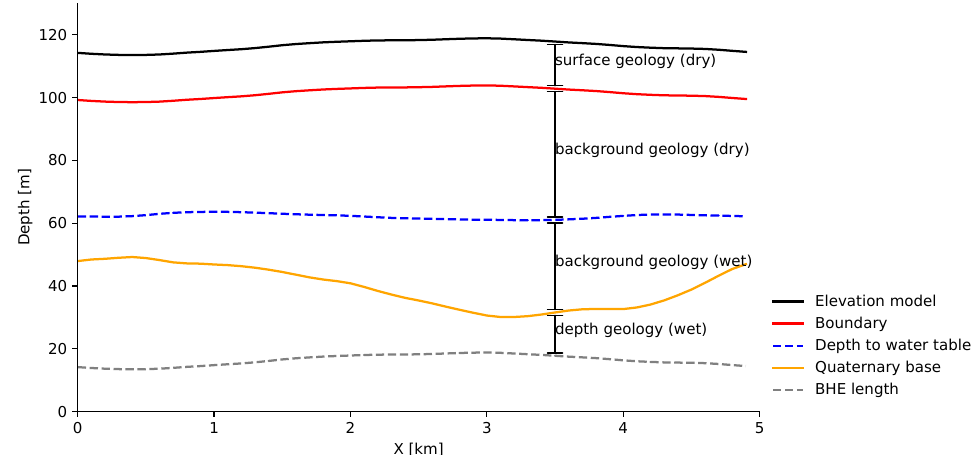
Figure 3. 2-D section trough a subset of the cartographic data to visualize the methodology used for the large-scale TC estimation.